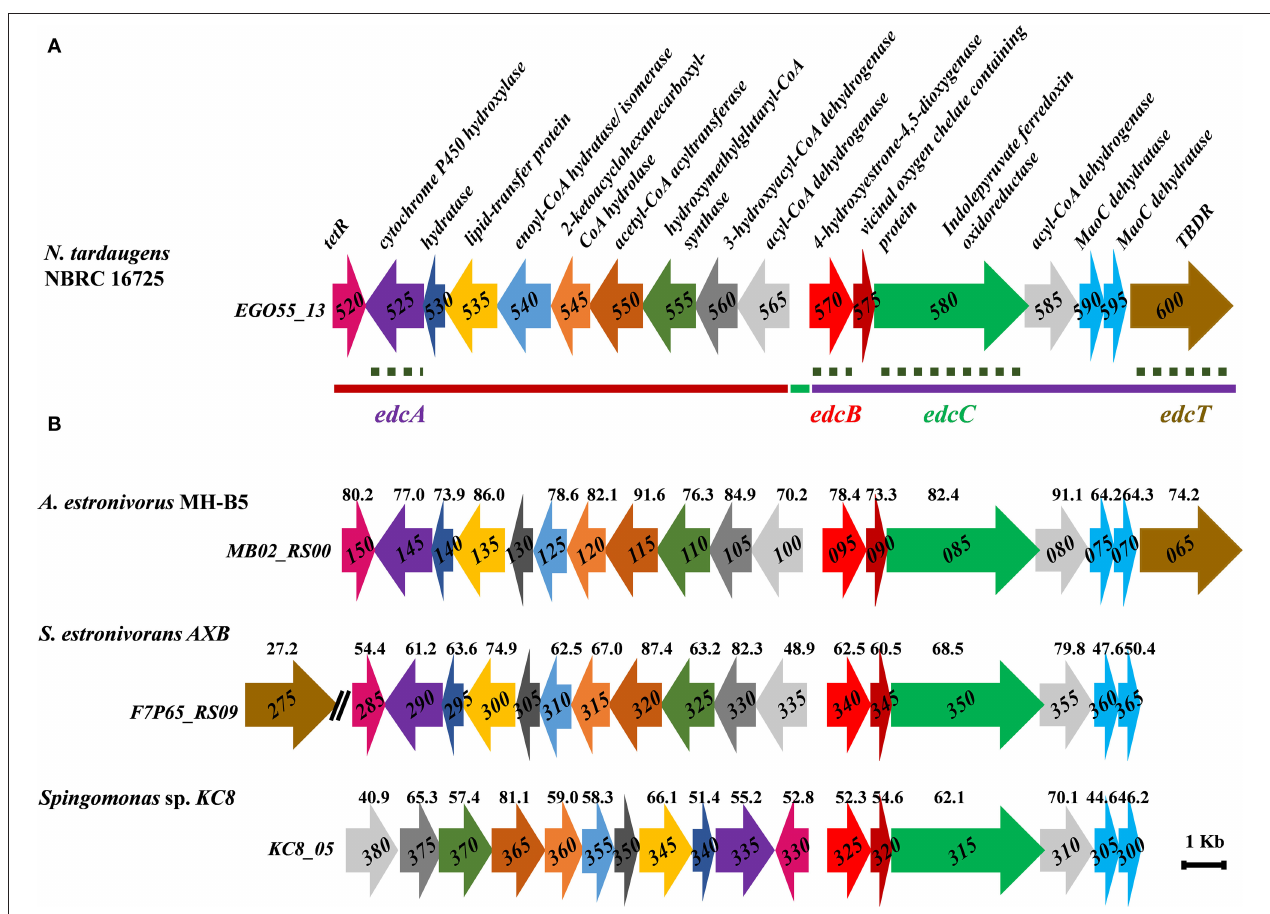
FIGURE 2 | (A) Scheme of the N. tardaugens NBRC 16725 estrogen degradation cluster ( edc ) (accession number CP034179). Regions deleted by double homologous recombination are depicted with a line: 1 Prom (green), 1 OpA (red), and 1 OpB (purple). Gene deletions by double homologous recombination that allowed function confirmation in this study are marked with a dashed line ( edcA , edcB , edcC , and edcT ). (B) Estrogen degradation gene cluster of A. estronivorus MH-B5 (accession number NZ_JRQQ01000001.1), S. estronivorans AXB (accession number NZ_LFCT01000011.1), and Sphingomonas sp. KC8 gene cluster II (accession number CP016306). Genes encoding the same function are pictured in the same color and % identity of protein products toward those from N. tardaugens is shown.